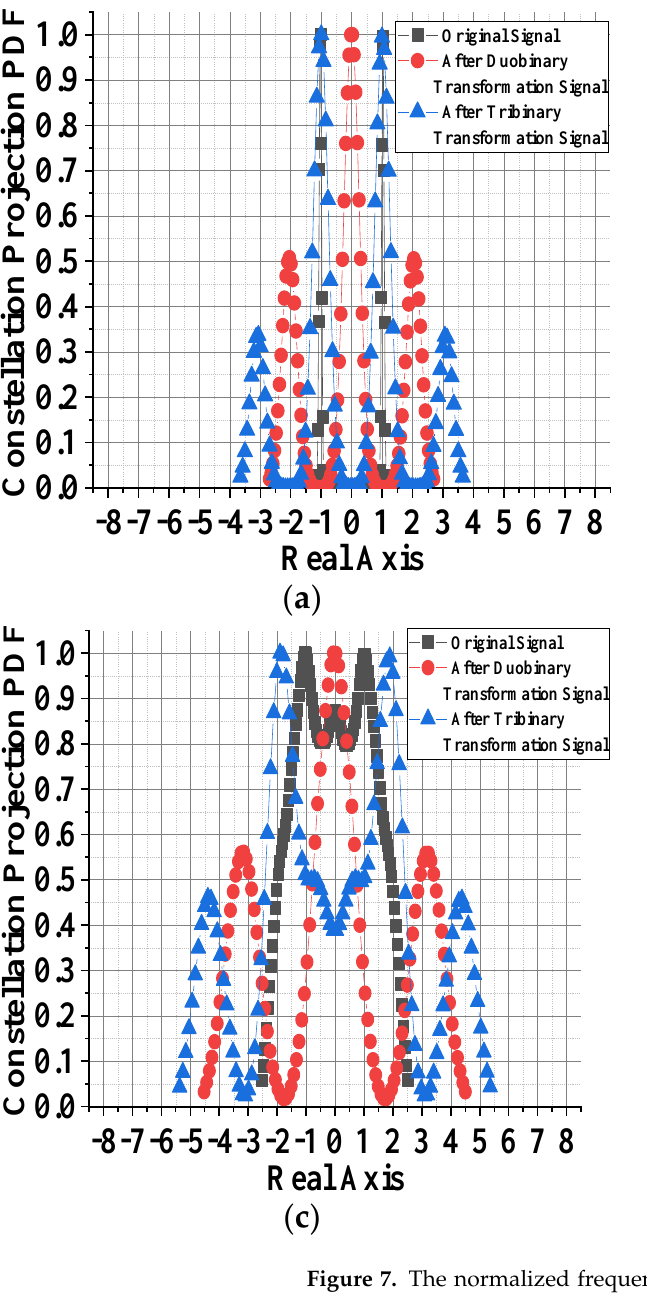
the three curves are the standard benchmark. For the smaller time-packing factors, the comparison results and analysis are shown as